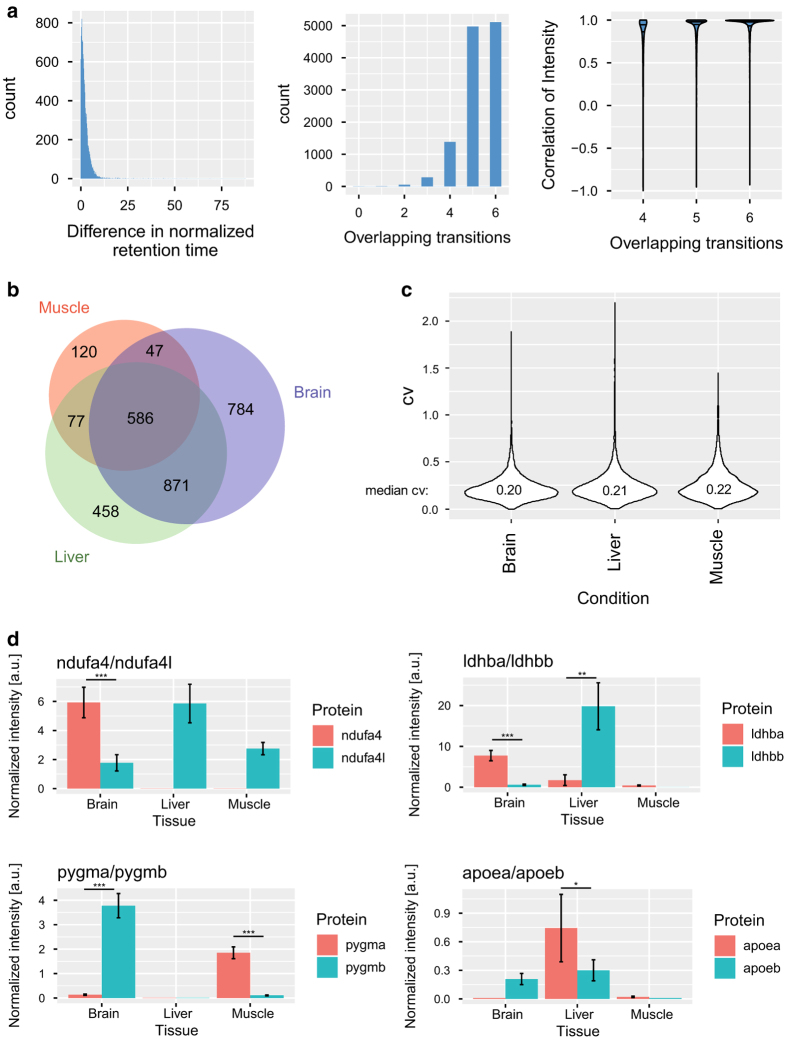
Quantification of the zebrafish proteome across brain, muscle and liver.(a) Comparison of the SWATH assay coordinates to quantify the 10,115 peptides common to both the zebrafish and human SWATH spectral library17. Plotted are the difference in retention time normalized to iRT peptides37 for the 11,816 precursor ions present in both libraries, how many of the 6 fragment ions per precursor (70,896 fragment ions in total) are identical, and the correlation of the relative intensities for the 11,463 precursor ions with at least 4 overlapping transitions. The horizontal lines in the violin plots depict the quartiles. (b) Overlap of proteins quantified across three different zebrafish tissues. (c) Coefficient of variation of the quantified signal for protein abundance across 6 fish. (d) Protein abundance of ohnologues across the three zebrafish tissues. The error bars represent standard deviation of six different fish and the difference in abundance was tested using an unpaired t-test for ohnologues quantified in the same tissue (∗∗∗adj. p-value<0.001, ∗∗adj. p-value<0.01, ∗adj. p-value<0.05, n.s. adj. p-value>0.05).